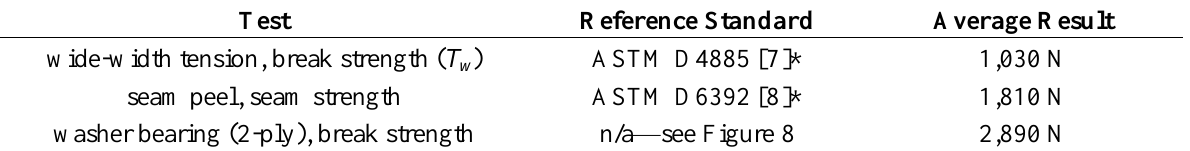
Table 3. Summary of geocell laboratory test results performed by